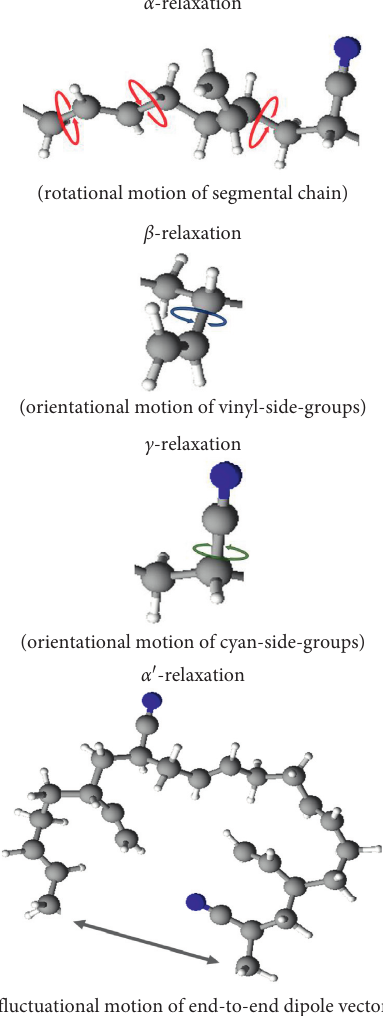
Figure 7: Assignment of the dielectric relaxation process for the schematic molecular chain structure and its motion mode in